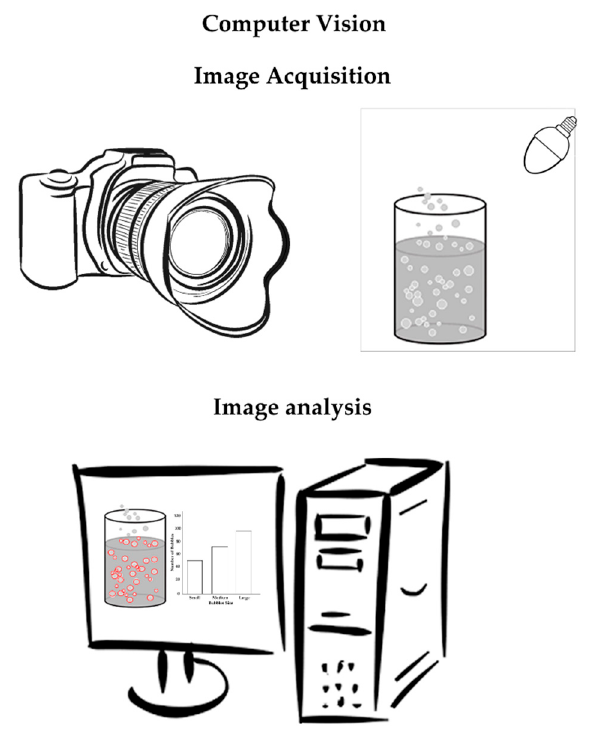
Figure 1. Diagram showing the equipment typically needed for computer vision (CV) analysis, which consists of a camera, the sample, a light-source, and computer software for analysis .